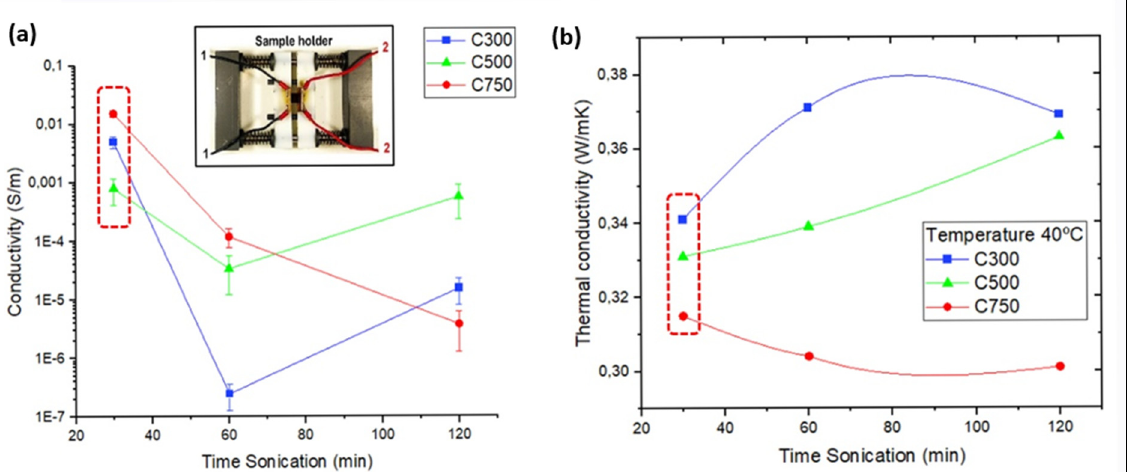
Figure 7. Electrical ( a ) and thermal ( b ) conductivity of GNP/epoxy composites, applying different ultrasonic dispersion times 30, 60, and 120 min. The red box indicates the conductivity values for the optimum sonication time for which the best thermoelectric properties are obtained. The image of graph ( a ) shows the conductivity measuring instrument at four points.